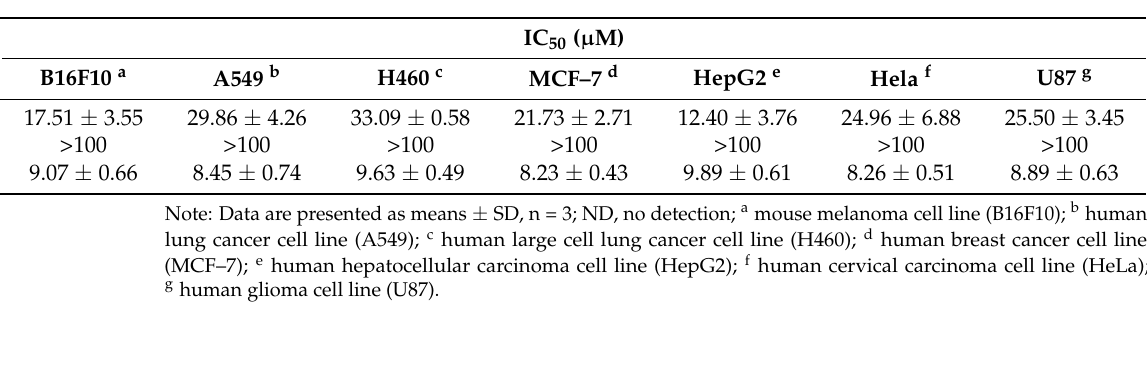
Table 3. Cytotoxic activity of compounds 1 and 2 against seven tumour cell lines in